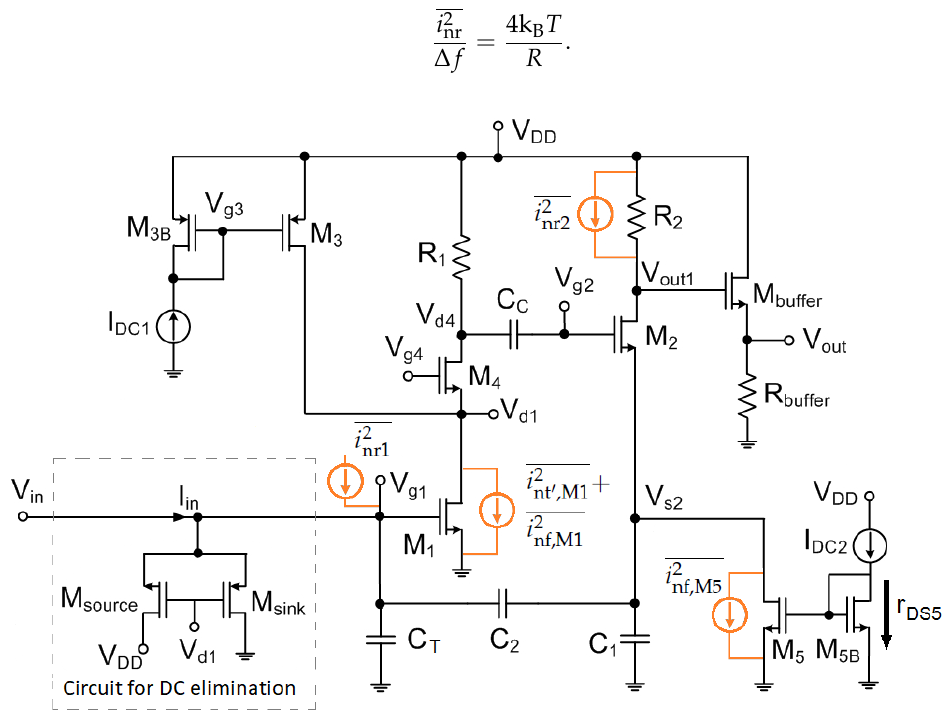
Figure 2. A circuit-level implementation of a fixed-gain capacitive feedback TIA and contributing noise sources: (1) thermal noise due to R bias,1 , (2) thermal noise due to R 2 , (3) M 1 thermal noise, (4) M 1 flicker noise, and (5) M 5 flicker noise (adapted from